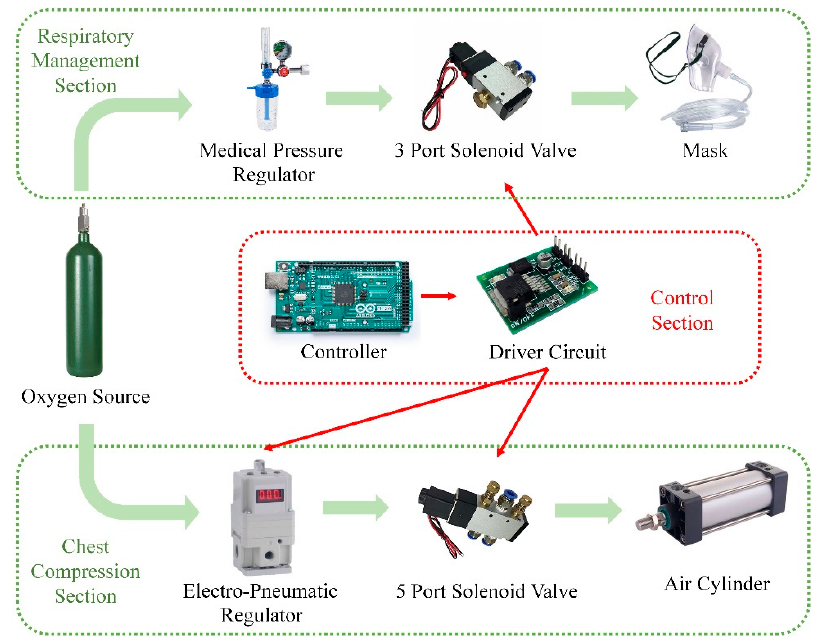
Figure 2. The system architecture of the novel CPR prototype. The green boxes are the respiratory management section and the chest compression section, and the red box is the control section. The green arrow indicates the flow of oxygen, and the red arrow indicates the control signal.